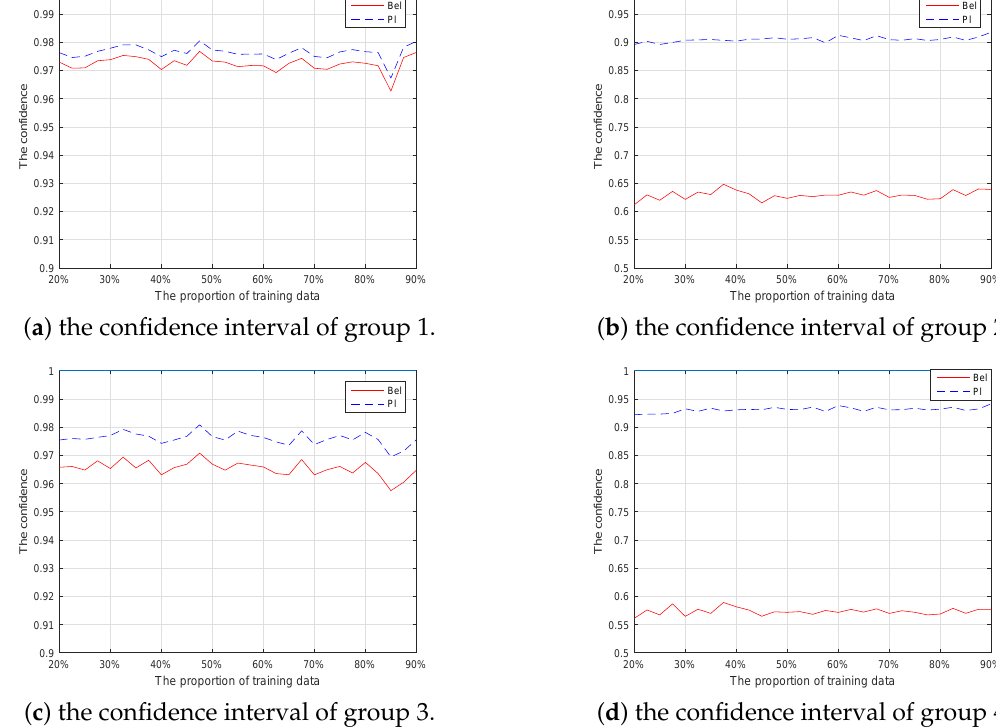
( d ) the confidence interval of group 4. Figure 5. The confidence intervals of the